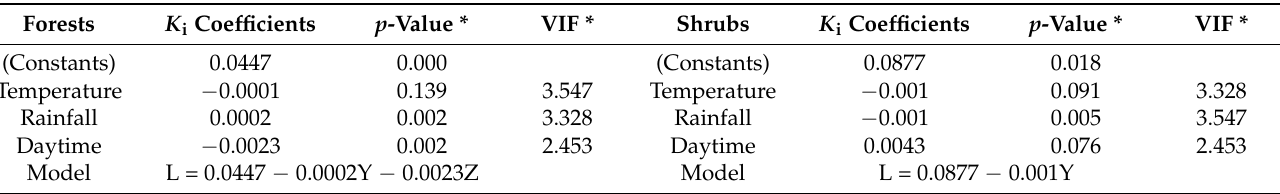
Table 8. Vegetation regeneration period model results.